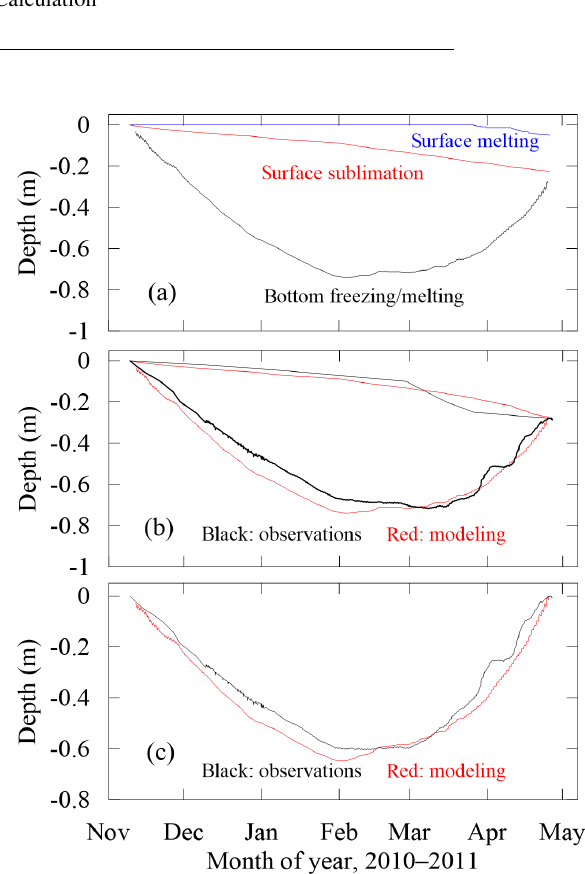
Figure 4. The HIGHTSI modeled BLH lake ice mass balance com- ponents (a) , the ice surface and bottom evolution (b) , and the ice thickness (c)